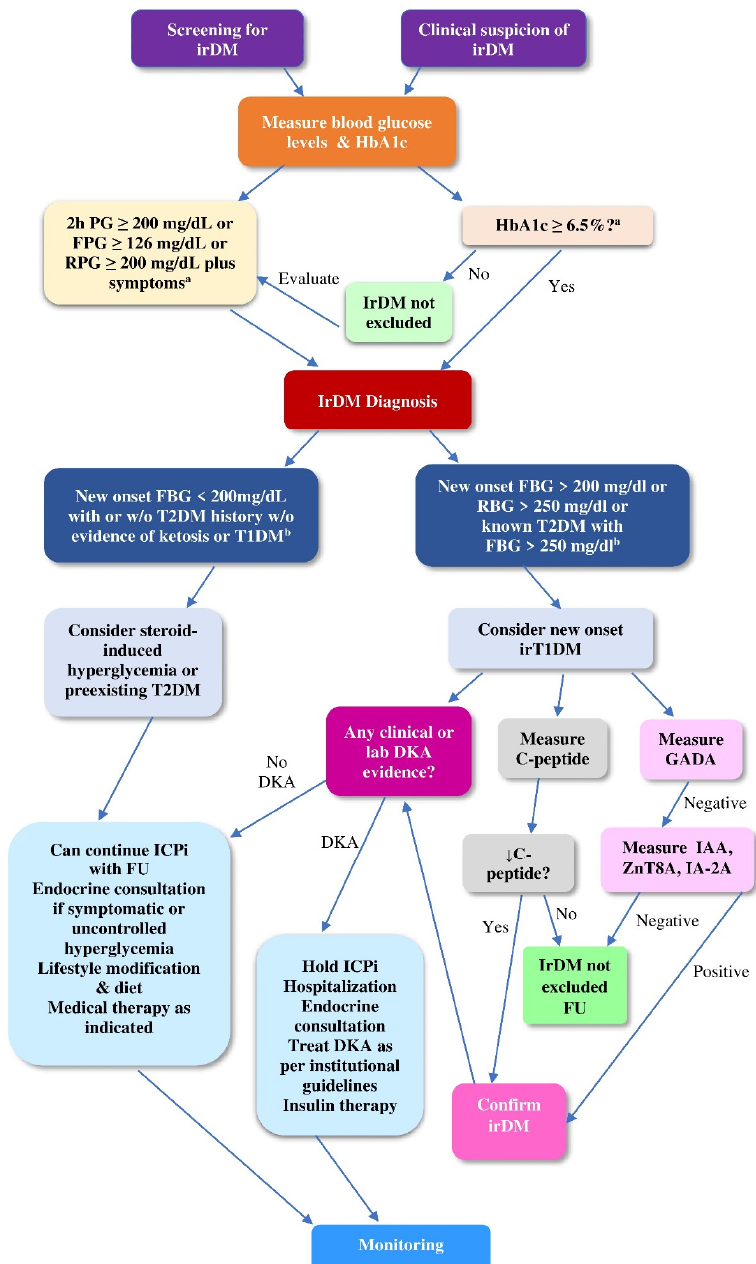
Figure 5. Stepwise decision making on irDM integrating the diagnostic work-up, the treatment, and the continuation or withdrawal of ICPi treatment. a According to American Diabetes Association; 2. Classification and Diagnosis of Diabetes: Standards of Medical Care in Diabetes—2020 [13]. b Ac- cording to the NCCN Clinical Practice Guidelines in Oncology for management of Immunotherapy- Related Toxicities, Version 1.2019 [6] Abbreviations: DKA, diabetic ketoacidosis; FPG, fasting plasma glucose; FU, follow-up; GADAs, glutamic acid decarboxylase autoantibodies; HbA1c,